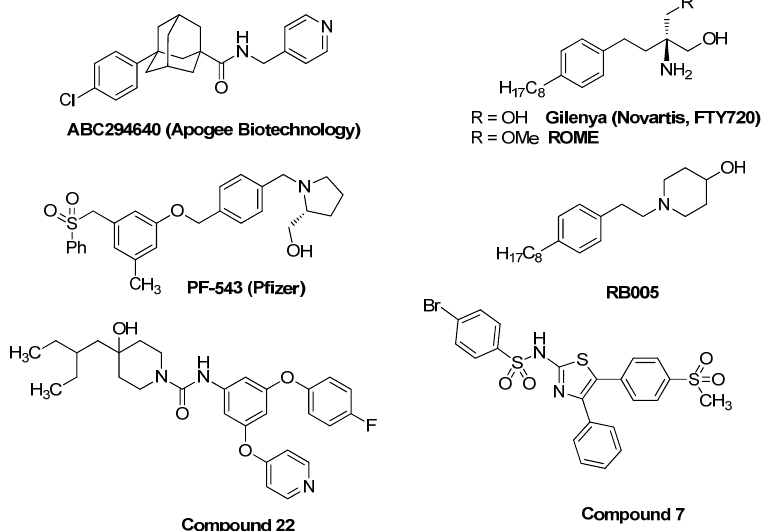
Figure 1. Known sphingosine kinase inhibitors.